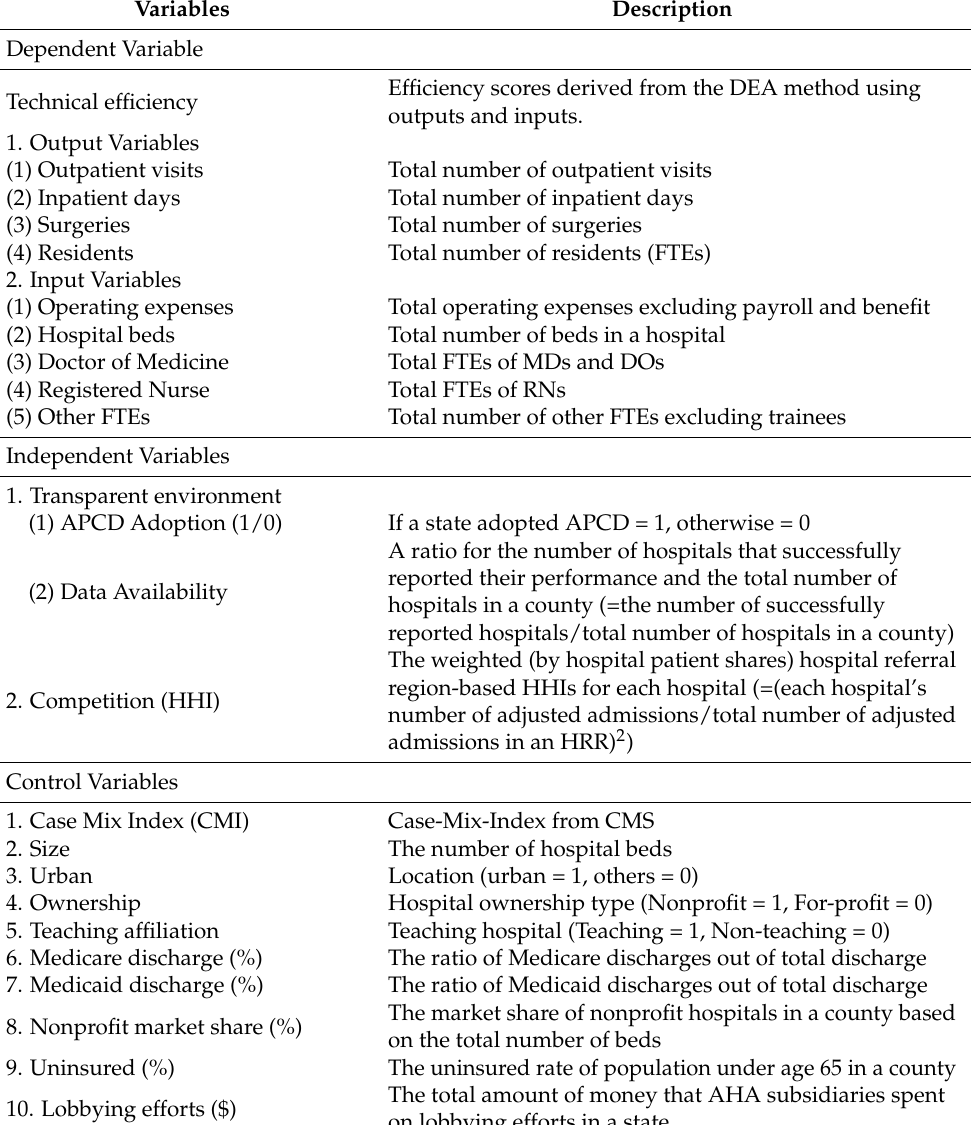
Table 1. Description of